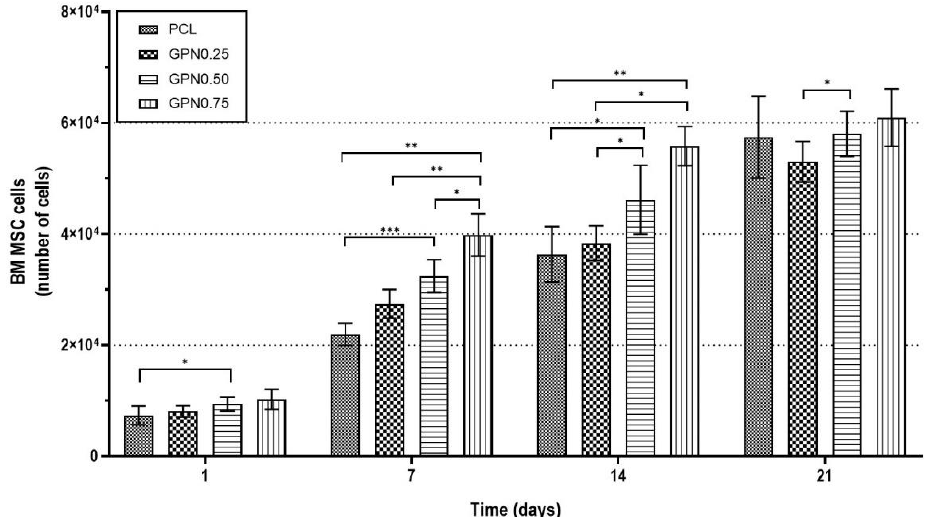
Figure 7. Biological in vitro testing of scaffolds with BM MSC: cell proliferation assessment. Two-way ANOVA, uncorrected Fisher’s LSD ( n = 3), multiple comparisons. Statistical differences: * p < 0.05; ** p < 0.01; *** p < 0.001.